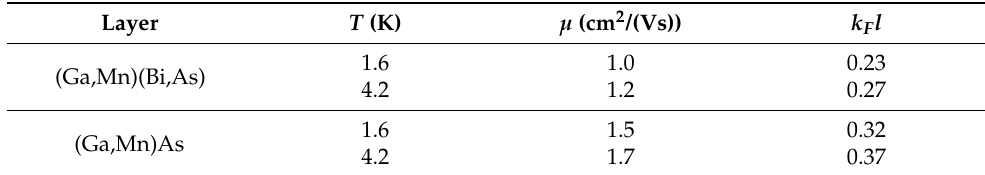
Table 2. Hole mobilities, µ , and disorder parameter, k F l , derived from the fitted ρ c and measured p values. Layer T